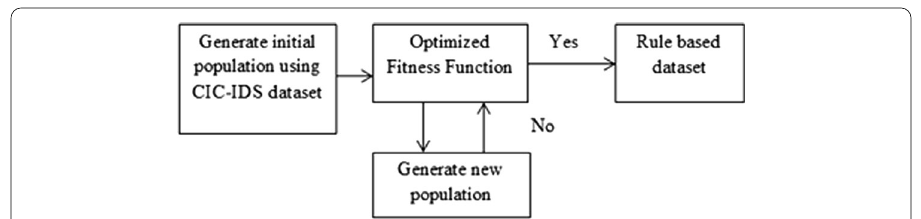
Fig. 3 Genetic algorithm process for rule based dataset generation. Genetic algorithm is used to generate rule based dataset. Process works in four steps as initial population generation for features selected from CIC-IDS dataset. This dataset consist of more than 80 features out of that only 22 features are used to describe normal behavior of the packet in the network. Optimized set of features is finalized using fitness function. All the features with good fitness value are considered for rule dataset generation. Process continues until optimized set is